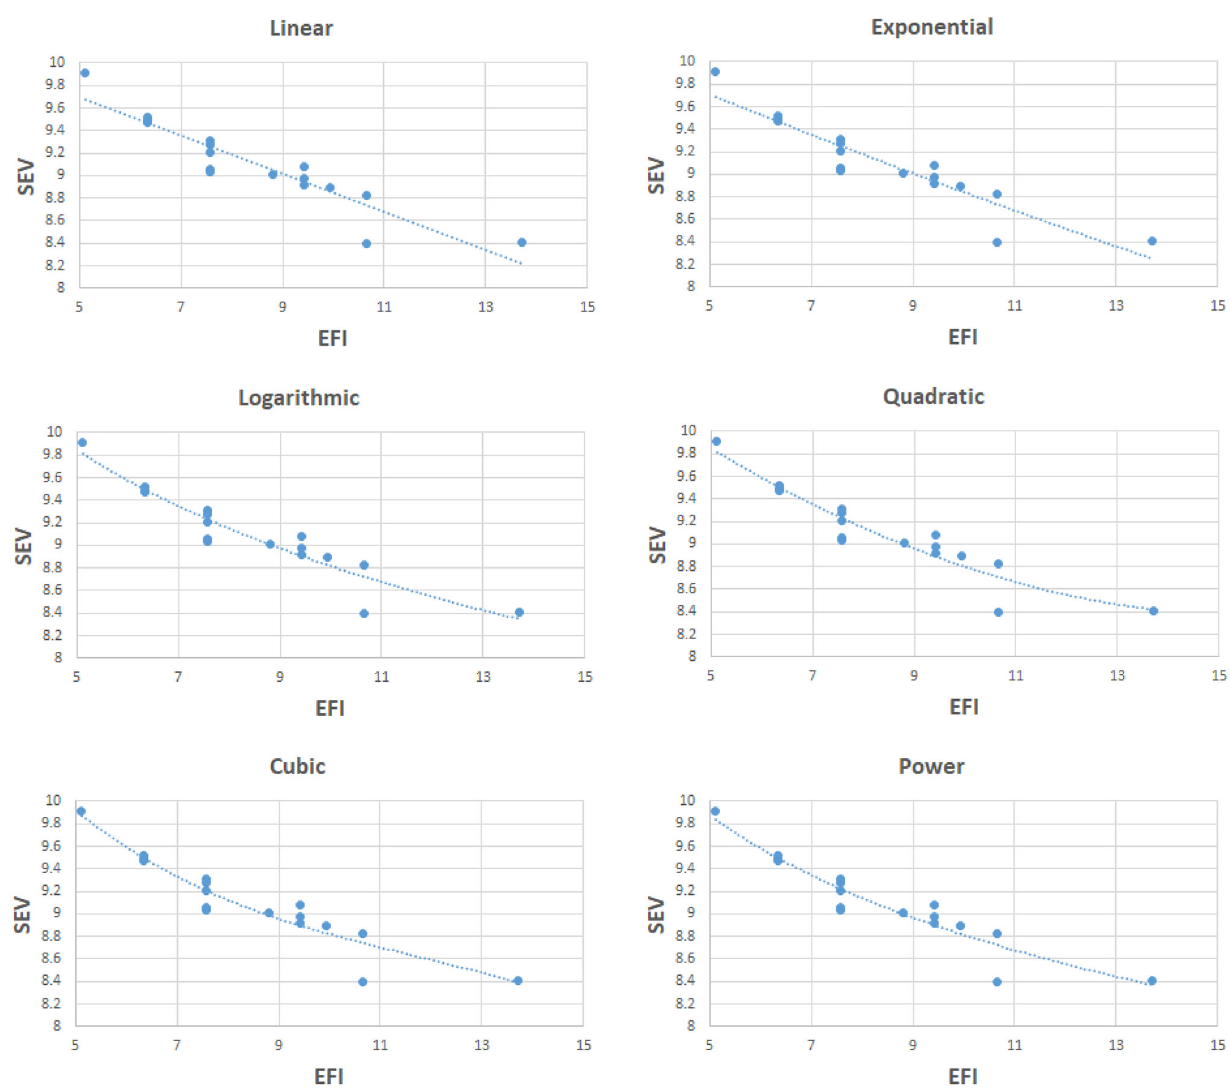
Fig. 4 The correlation of edge F-index with standard enthalpy of vaporization for octane